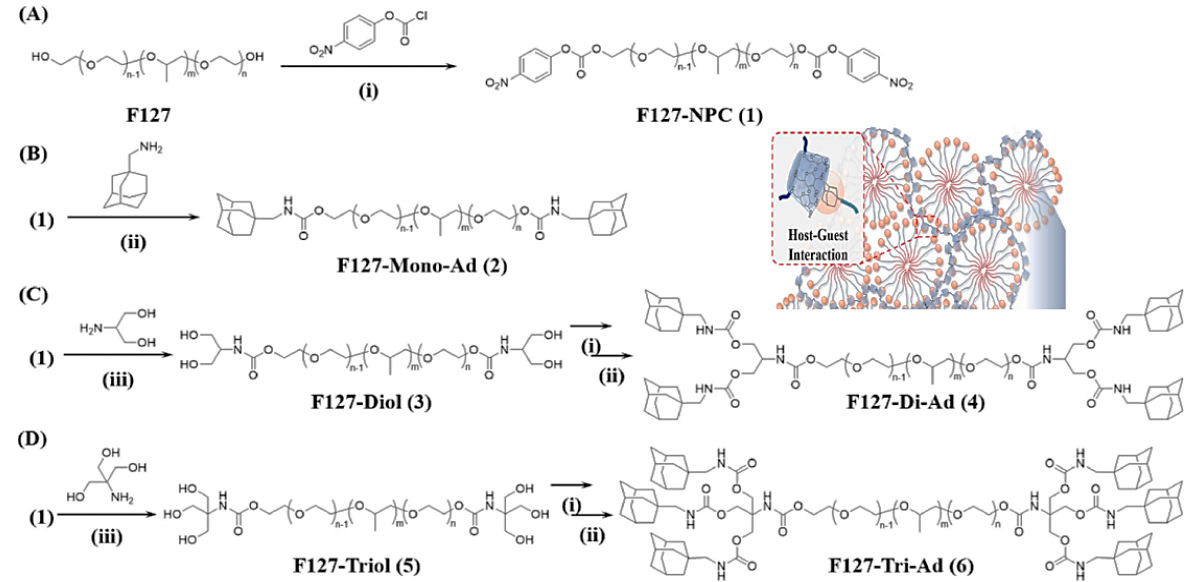
Figure 6. Synthetic ( A ) F127-NPC, ( B ) F127-Mono-Ad, ( C ) F127-Di-Ad, and ( D ) F127-Tri-Ad. and host–guest interaction with β -cyclodextrin, which assembles into micells (adapted with permission from Lee et al., 2021).